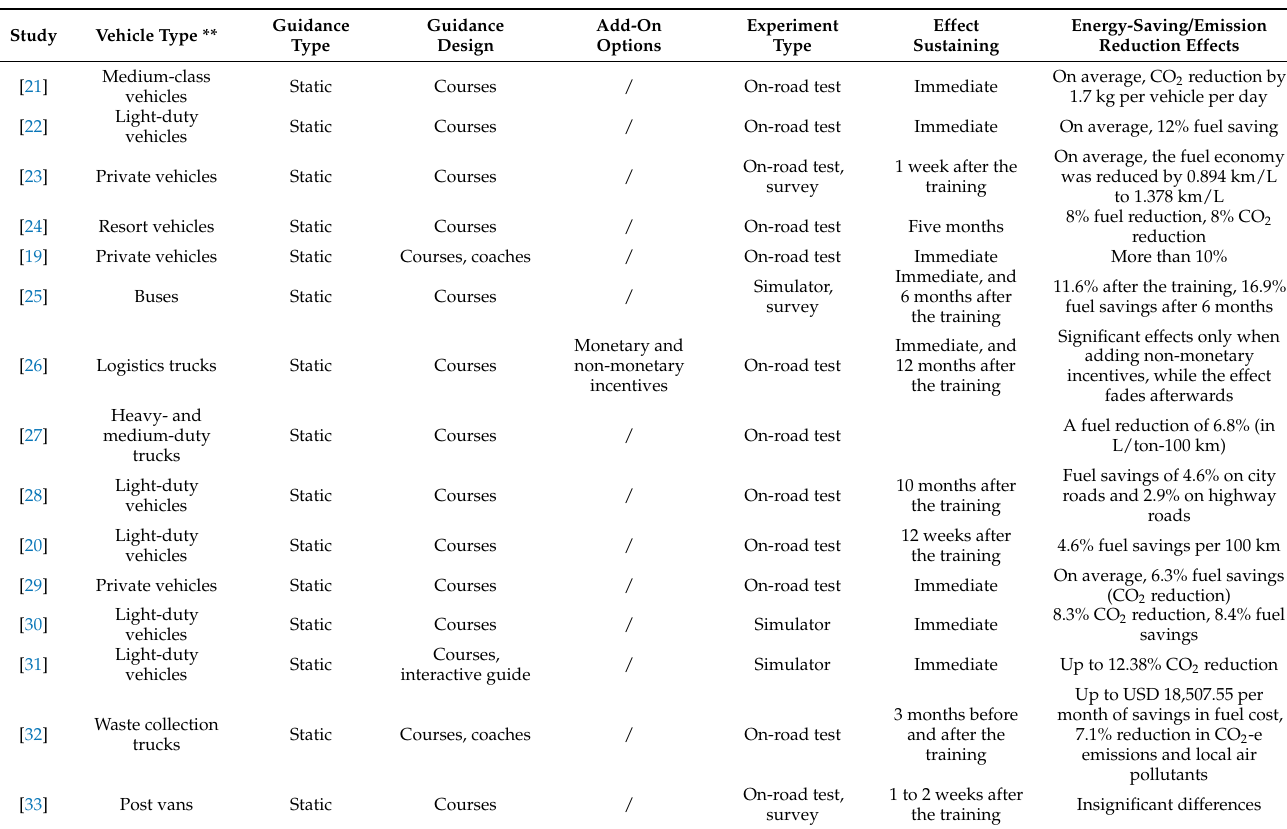
Figure 1. System elements and experiment design of two types of eco-driving guidance (where “S” means the item is only available in static guidance, “D” means the item is only available in dynamic guidance, and “S/D” represents the item is applicable for both static and dynamic guidance). Table 1. Effects of static eco-driving guidance on energy savings and emission reductions